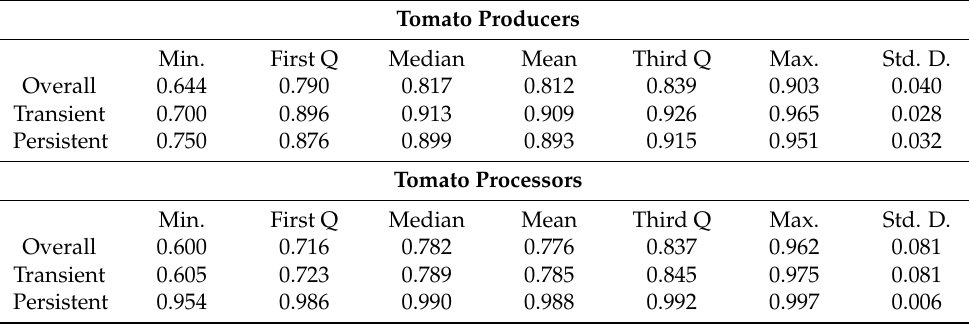
Table 5. Technical efficiency. Source: authors’ calculations.